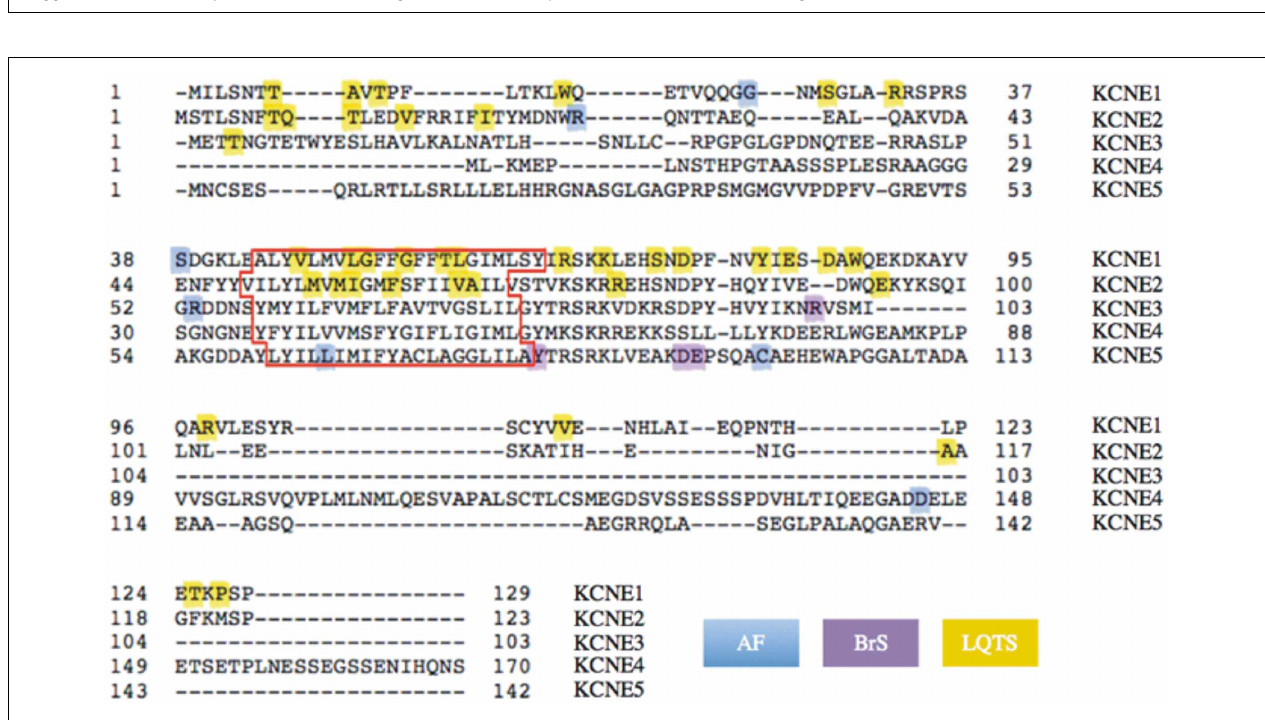
Extracellular side is uppermost in each case. (B) Upper , a ventricular action potential waveform indicating the major ionic currents that contribute to its morphology and duration; lower , a human surface ECG waveform showing the QT interval.